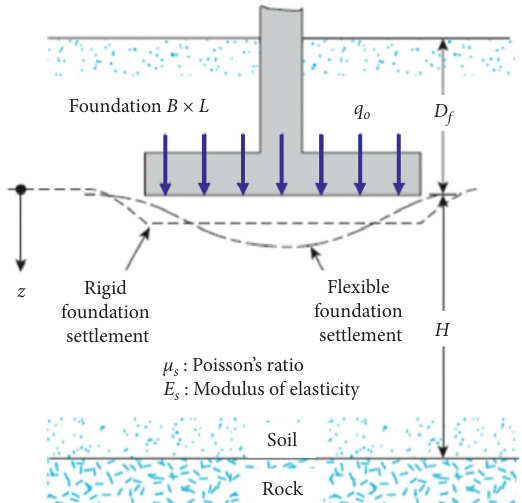
Figure 1: Some of the related variables on foundation-soil